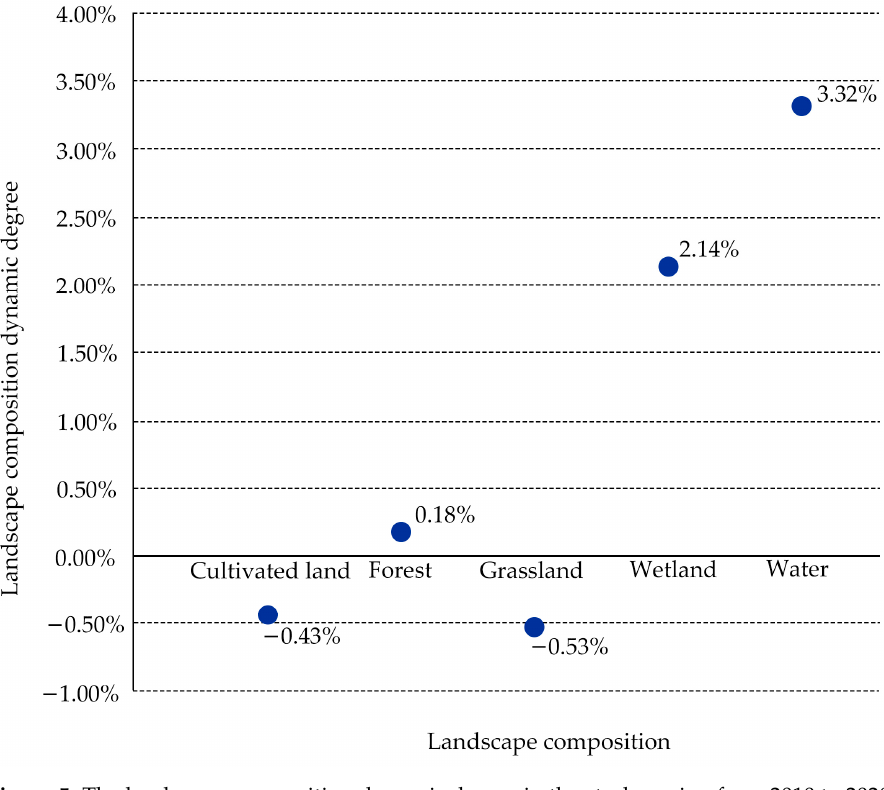
Figure 5. The landscape composition dynamic degree in the study region from 2010 to 2020.